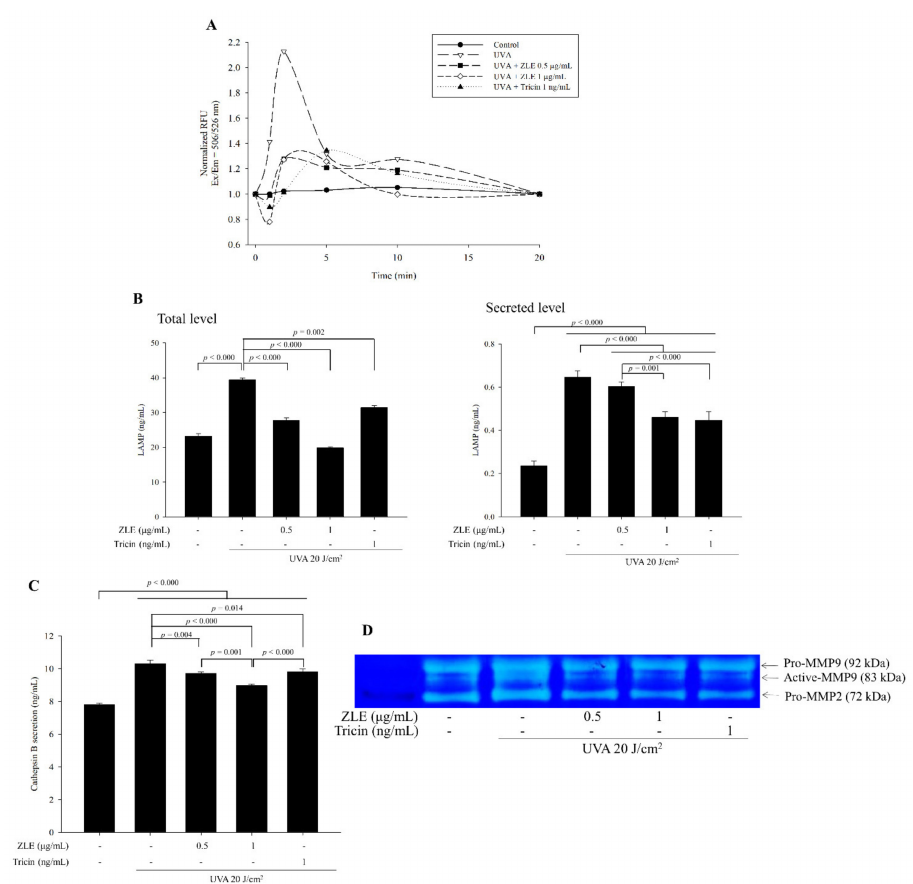
Figure 3. Enzyme-treated Z. latifolia extract (ZLE) and tricin suppress calcium influx and lysosomal exocytosis caused by UVA irradiation in